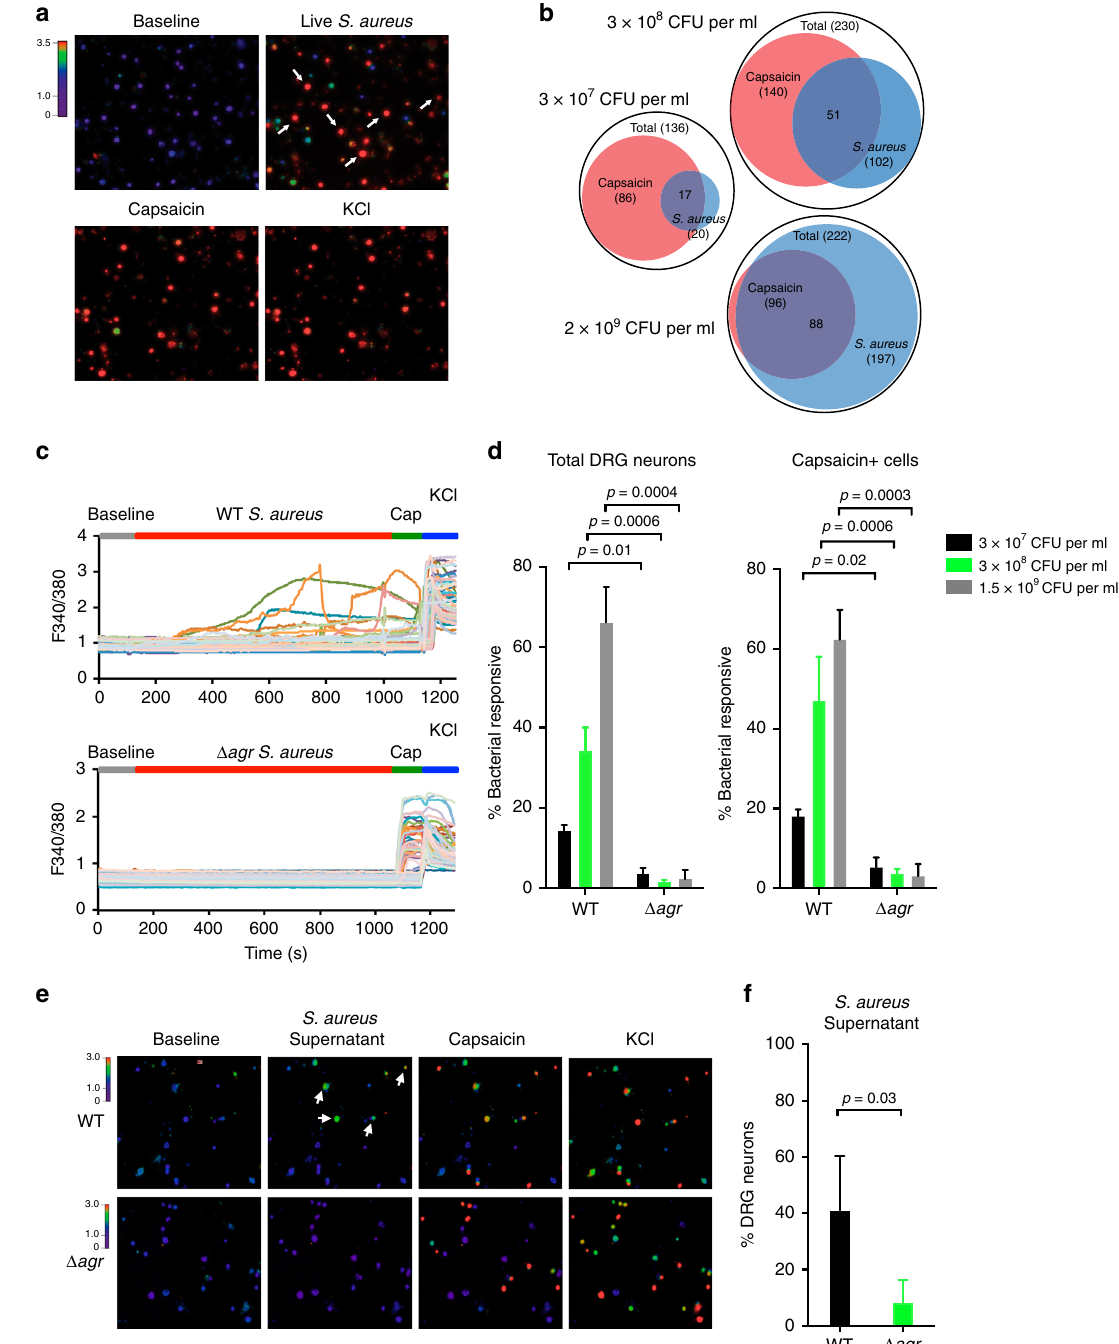
Fig. 2 Live S. aureus directly induces DRG neuronal responses dependent on the agr virulence determinant. a Representative fi elds of Fura-2 calcium imaging of DRG sensory neurons exposed to live S. aureus (USA300, 2 × 10 9 CFU per ml), followed by capsaicin (1 μ M) to activate nociceptors, and KCl (40 mM) to depolarize all sensory neurons. Arrows indicate neurons responding to bacteria. b Venn diagrams showing subsets of DRG neurons responding to different doses of live S. aureus or to the TRPV1 ligand, capsaicin. c Neuronal calcium traces from representative fi elds of neurons exposed to WT or Δ agr S. aureus (1.5 × 10 9 CFU per ml), followed by capsaicin (1 μ M), and KCl (40 mM). d Quanti fi cation of the proportion of total DRG neurons (left) or capsaicin + neurons (right) responding to WT or Δ agr S. aureus at three different bacterial doses: 3 × 10 7 CFU per ml: n = 3 fi elds each; 3 × 10 8 CFU per ml: n = 5 fi elds each; 1.5 × 10 9 CFU per ml: n = 4 fi elds each. p values, unpaired t test. e Representative imaging fi elds (arrows indicate neurons responding to bacterial supernatant) and f quanti fi cation of the proportion of neurons responding to culture supernatant from WT or Δ agr S. aureus . n = 4 fi elds (WT), n = 3 fi elds ( Δ agr ). a – d , N = 3 replicates; f , N = 2 replicates. p values, unpaired t test; error bars throughout fi gure, mean ±